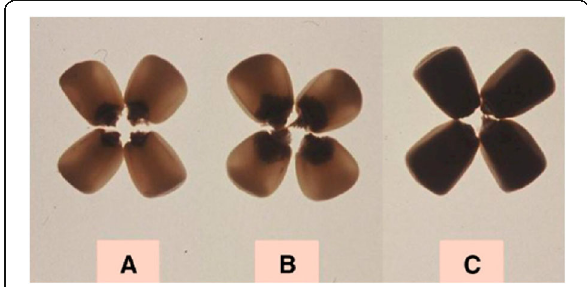
Fig. 1 Back-lit maize kernels illustrating the phenotypic differences of opaque2 mutation. a , b and c represent common maize, QPM and opaque2 maize, respectively. Taken from Nuss and Tanumihardjo